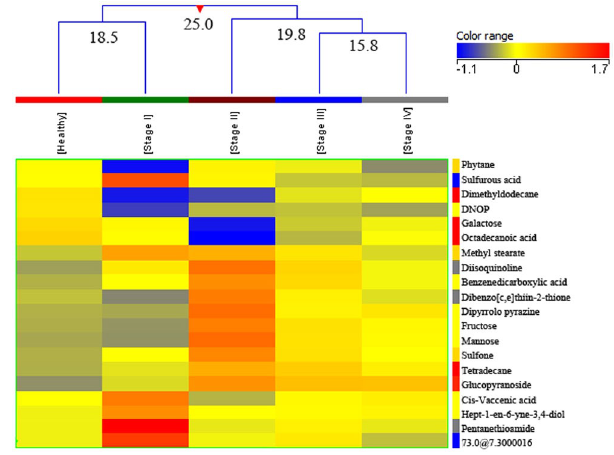
Figure 3. Dendogram showing comparison of five groups i.e. healthy controls, stage I, stage II, stage III and stage IV of Breast Cancer patients using normalized intensities of twenty significant metabolites (p < 0.05). The dendogram was constructed by applying a hierarchical clustering algorithm (Canberra, absolute distance metric, complete linkage). Compounds that have been identified have their name mentioned while one of the unidentified compound is recognized by its retention time. (DNOP - (1,2 Benzenedicarboxylic acid, bis (2-ethylhexyl) ester).